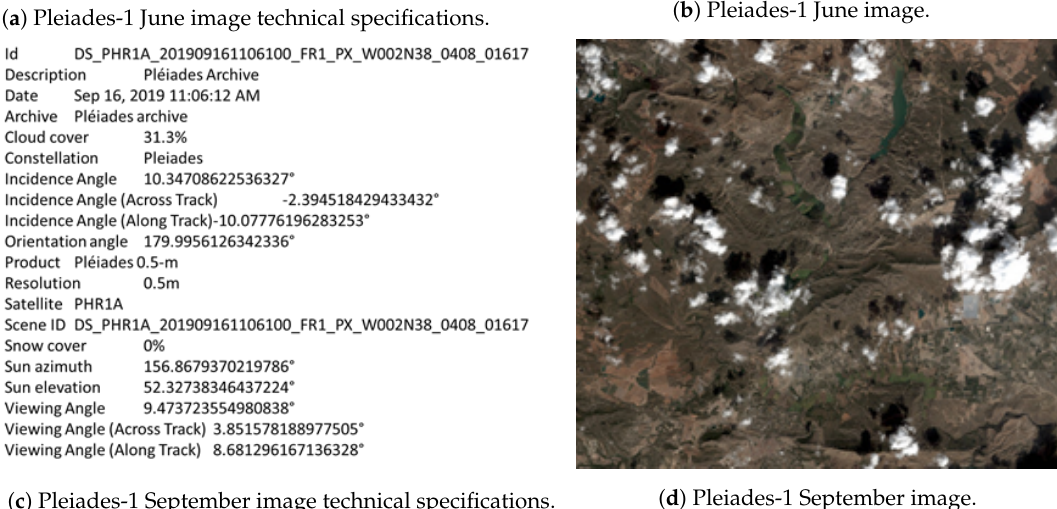
Figure 11. Pleiades-1 image used for control in June and